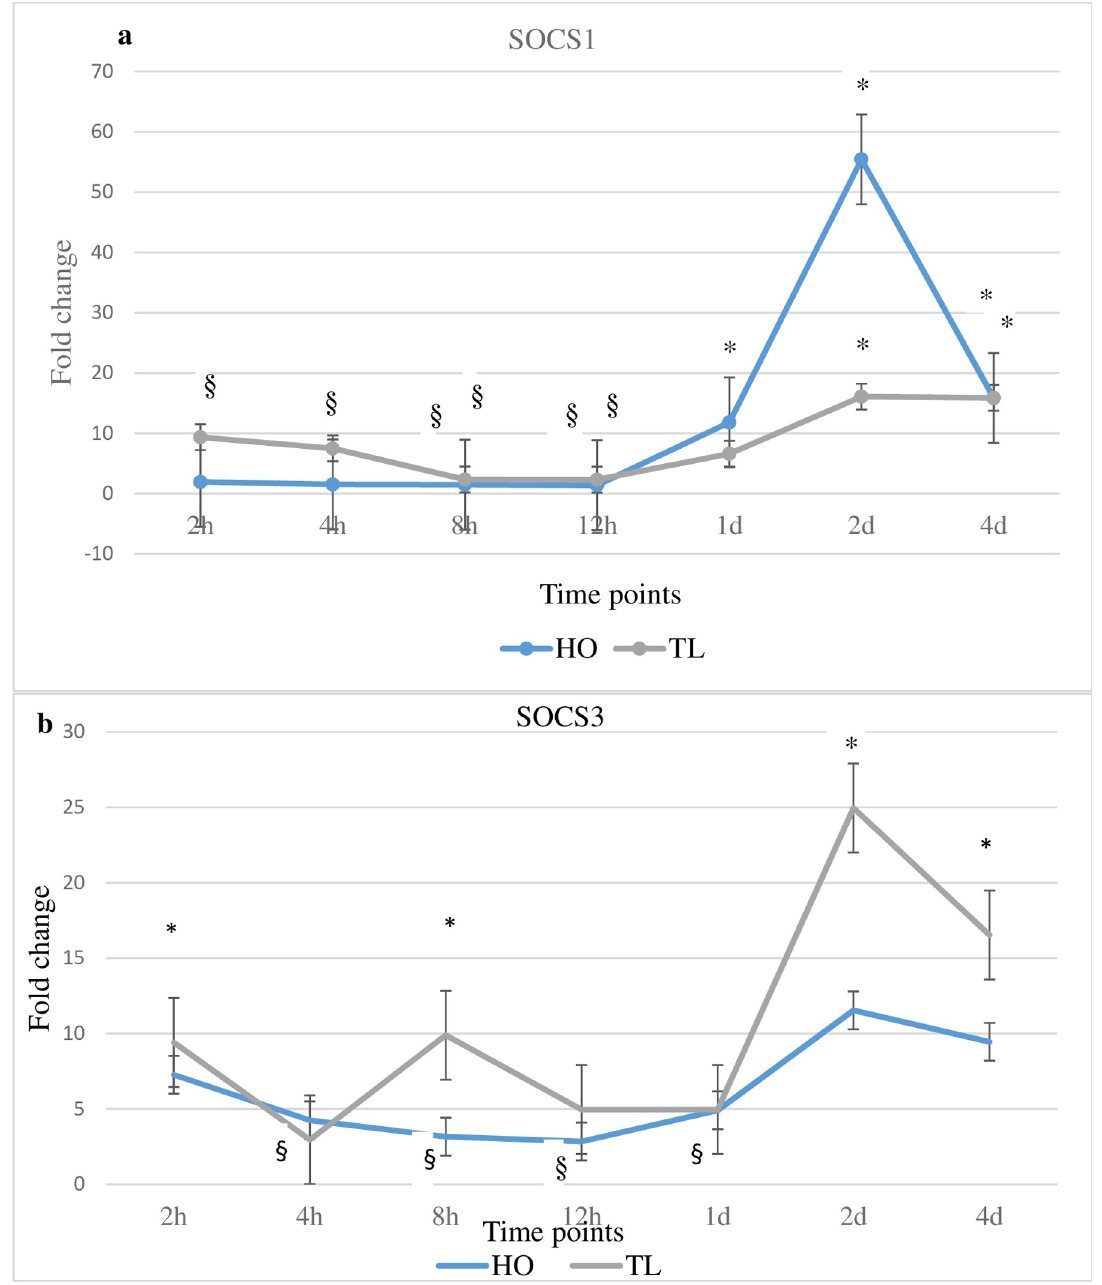
Fig 3. Transcription levels of SOCS1 and SOCS3. The figure shows the mean fold change of the genes in M . cerebralis exposed HO and TL fish. Lines are the mean fold change of IL-17A, IL-17C, IL-21 and ROR- γ measured at different time points post exposure hpe/dpe. All HO and TL means are presented normalized to HO and TL timed levels of control fish ± SD (n = 5). � = significantly higher and § = significantly lower to values in non-exposed fish (p < 0.05).